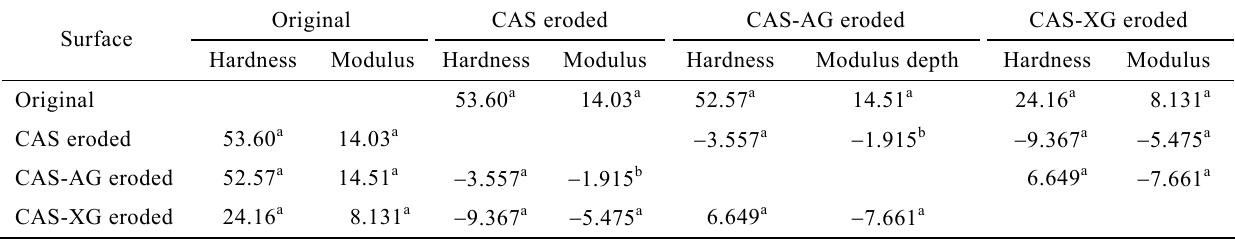
Table 2 Comparison of the hardness and elasticity modulus of enamel surfaces subjected to different erosion treatments by paired t-test ( P < 0.005).